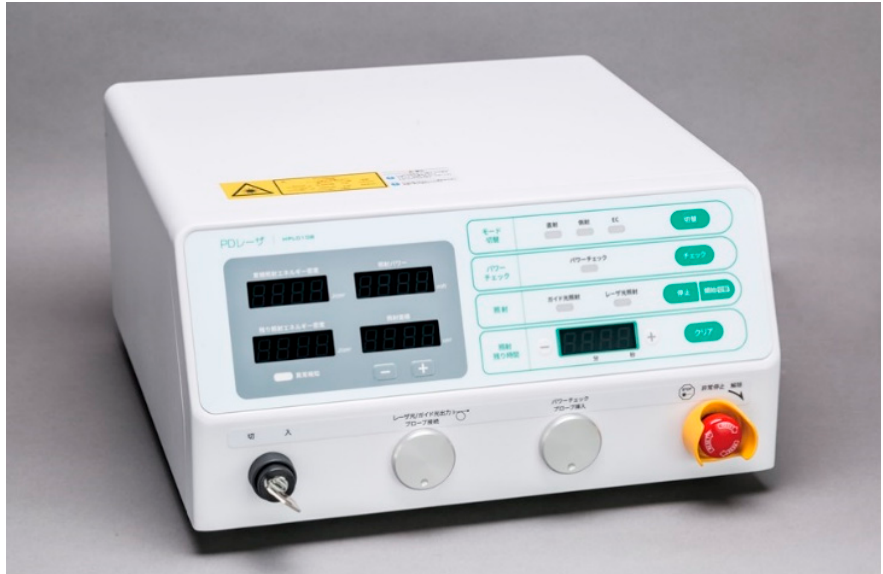
Figure 2. The system of a diode laser which can excite talaporfin sodium.